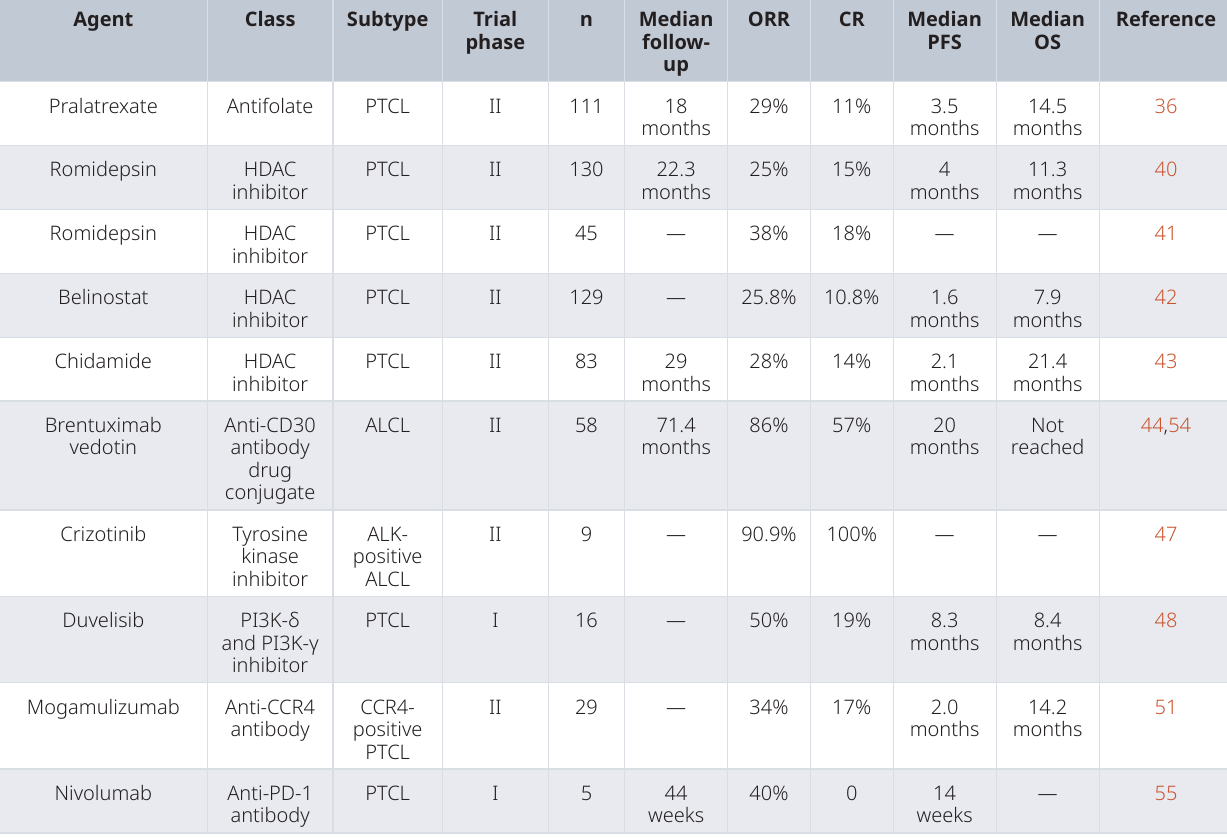
Table 1. Summary of select trials with targeted single agents in relapsed/refractory